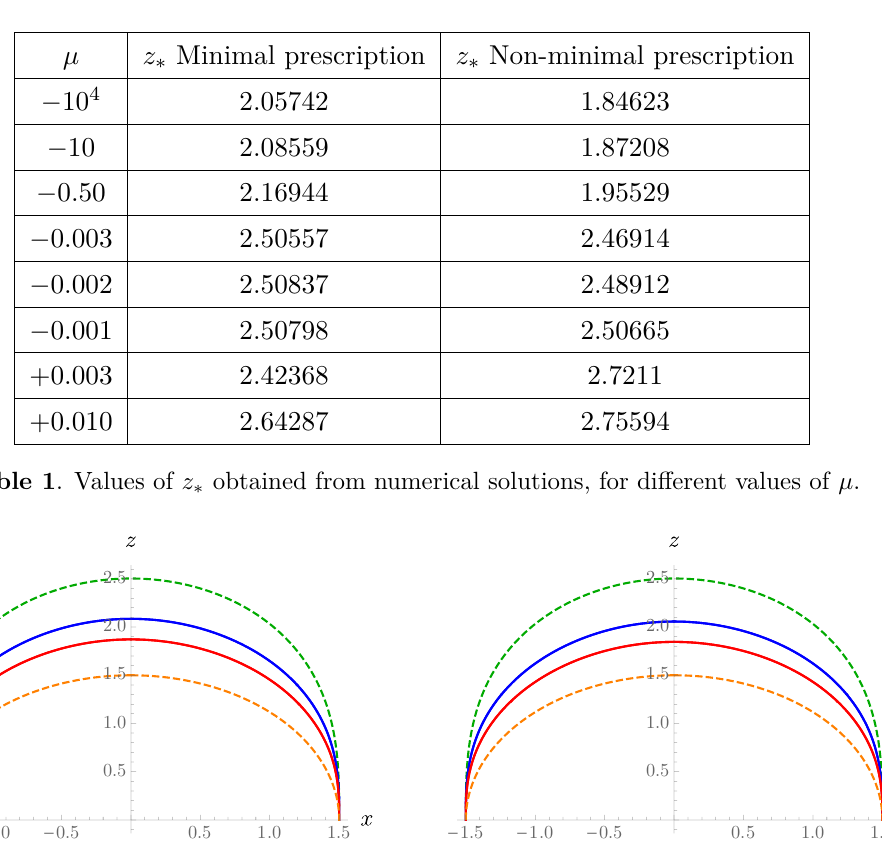
is satisfied c < z ∗